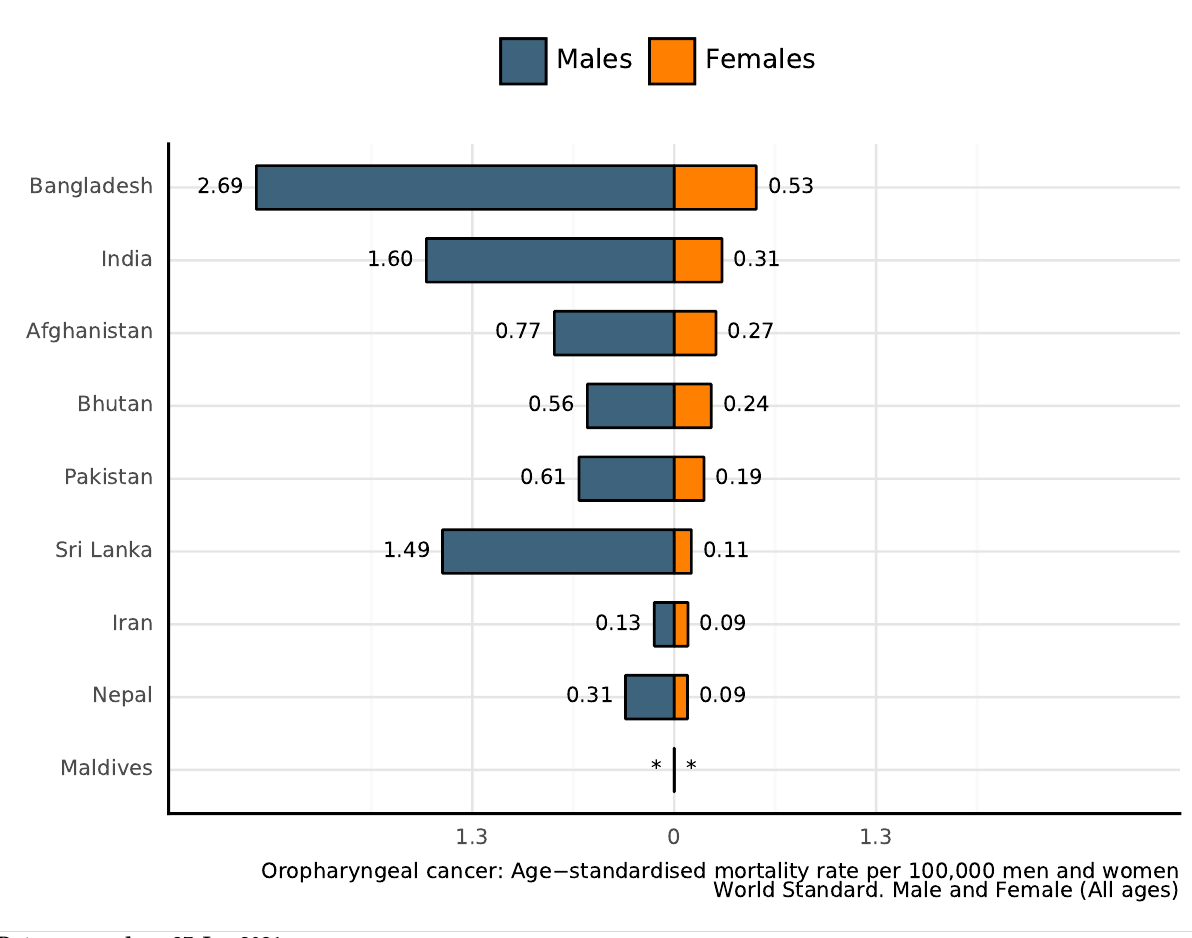
1.3 0 1.3 Oropharyngeal cancer: Age standardised mortality rate per 100,000 men and women World Standard. Male and Female